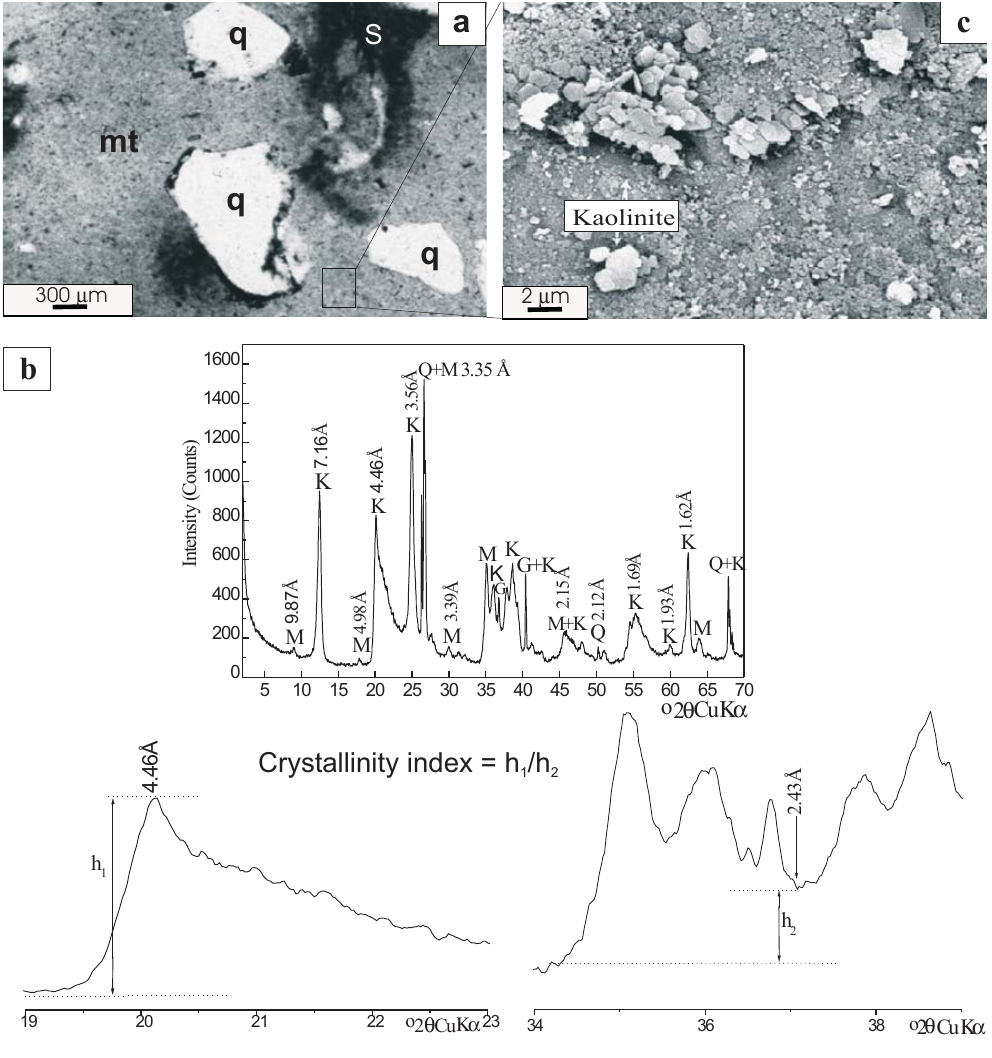
Fig. 5 – Friable clayey facies. a) Optical micrograph (plane-polarized light) showing quartzose (q) skeleton with pits of dissolution dispersed in the beige-white matrix (mt) with stains (s) of different sizes and different shades of red. b) X-ray diffraction pattern (Cu K α radiation) showing the composition of the white matrix: K= kaolinite, M = muscovite, G = goethite. The ratio h 1 /h 2 , where h 1 is the intensity above background of the reflection at 4.46 Å, and h 2 is the intensity above background at about 2.43 Å, indicates the measurement of the crystallinity index according to Hughes and Brown (1979). c) Scanning electron micrograph (SEM) showing hexagons of kaolinite, surrounded by poorly-defined and small crystals of